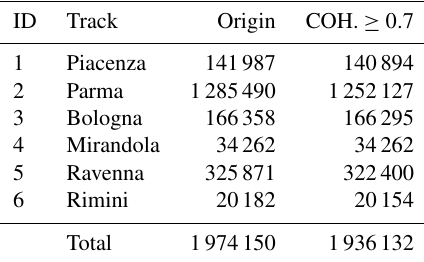
Table 2. Comprehensive list of radar targets before (Origin) and after (COH. ≥ 0 . 7) the application of coherence